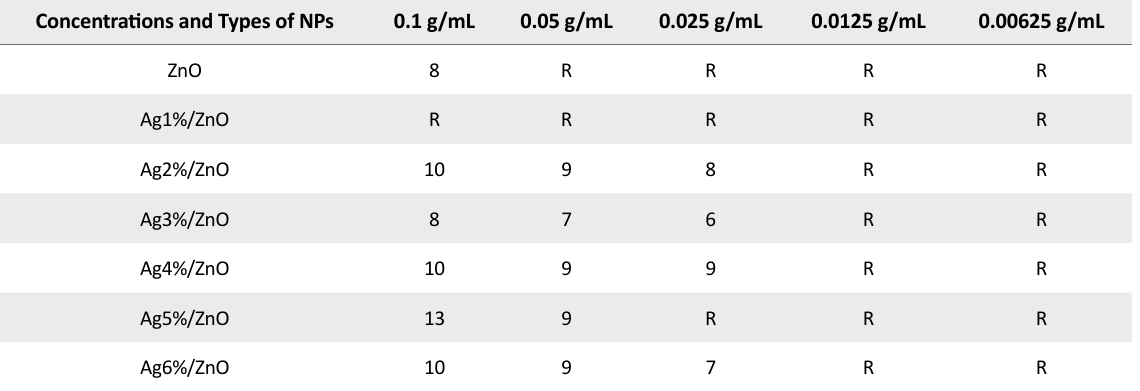
Table 4. Mean diameter of zone of inhibition (mm) against Escherichia coli at different concentrations Concentrations and Types of NPs